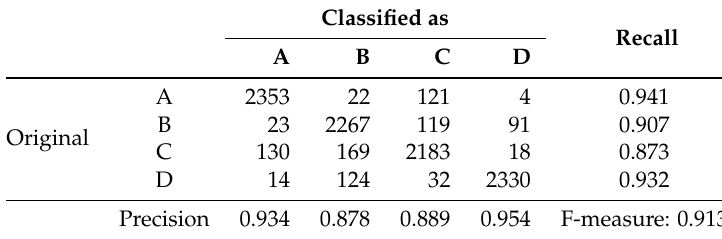
Table 9. Confusion matrix of label visibility classification with selected 15